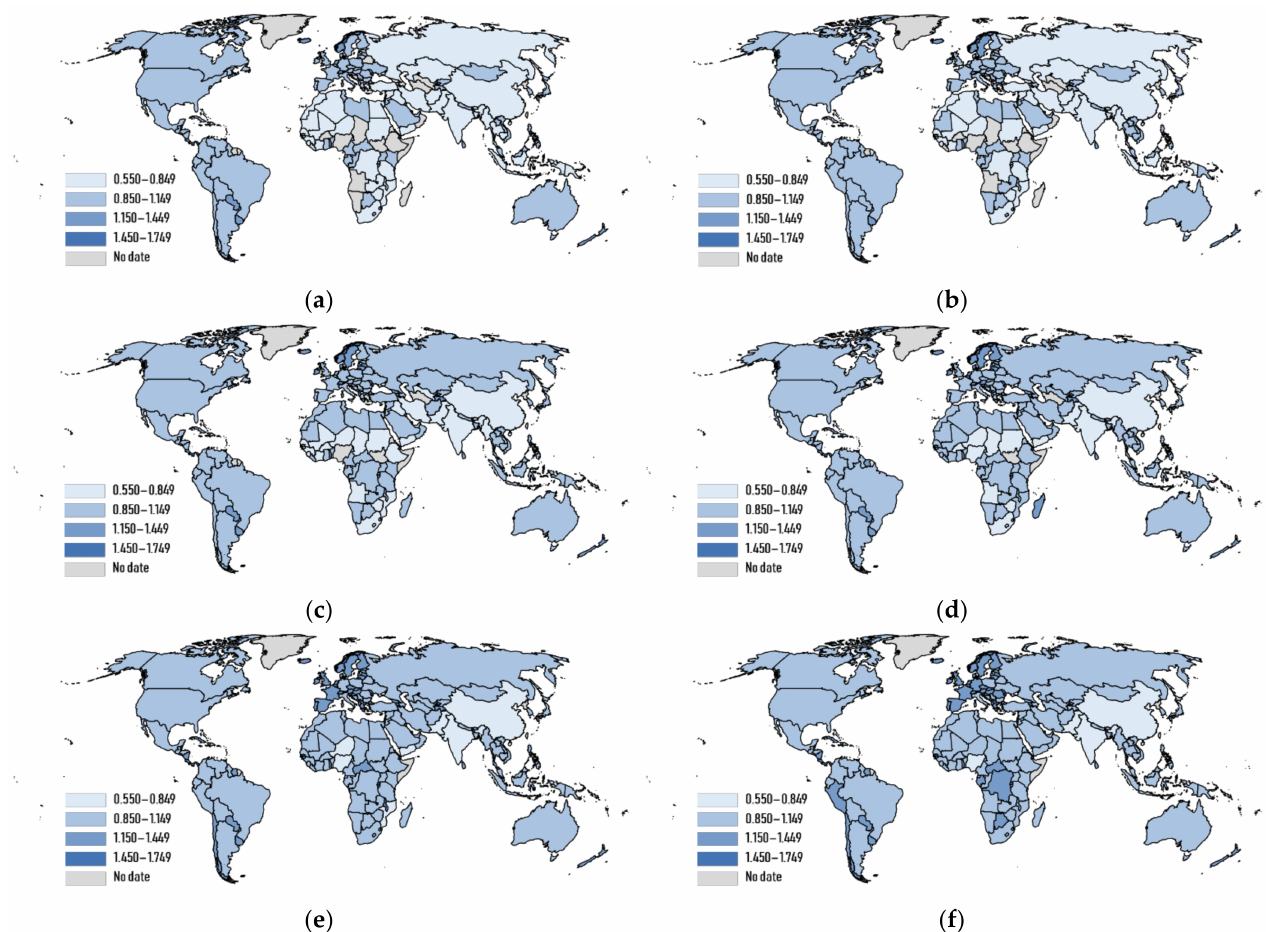
Figure 4. Evolution of carbon emission performance, 1990–2019. Source: Authors’ own construction using Excel. ( a ) 1990; ( b ) 1996; ( c ) 2002; ( d ) 2008; ( e ) 2014; ( f )